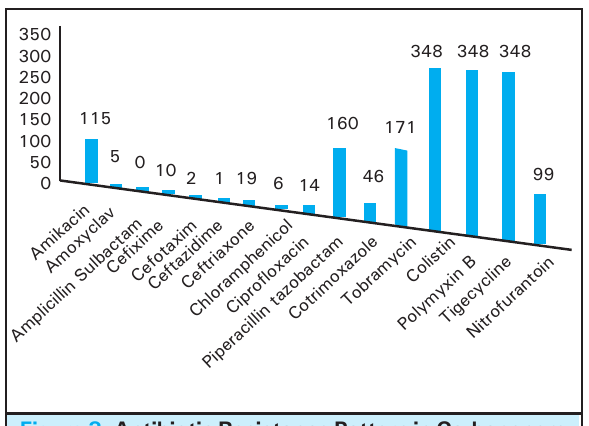
Figure 3. Antibiotic Resistance Pattern in Carbapenem Resistant